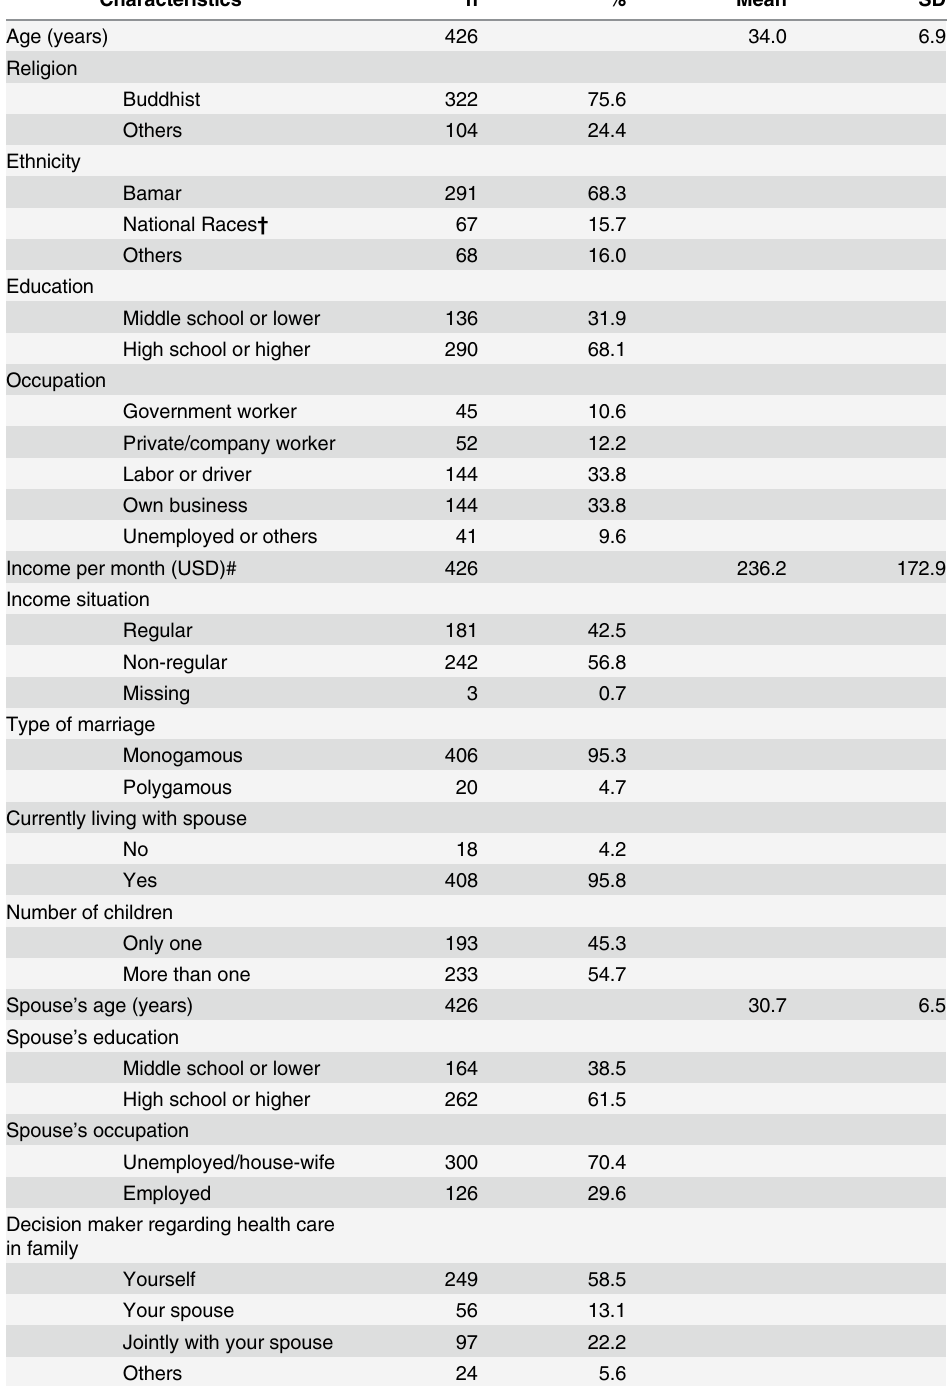
Table 1. Background Characteristics of Participants (n =